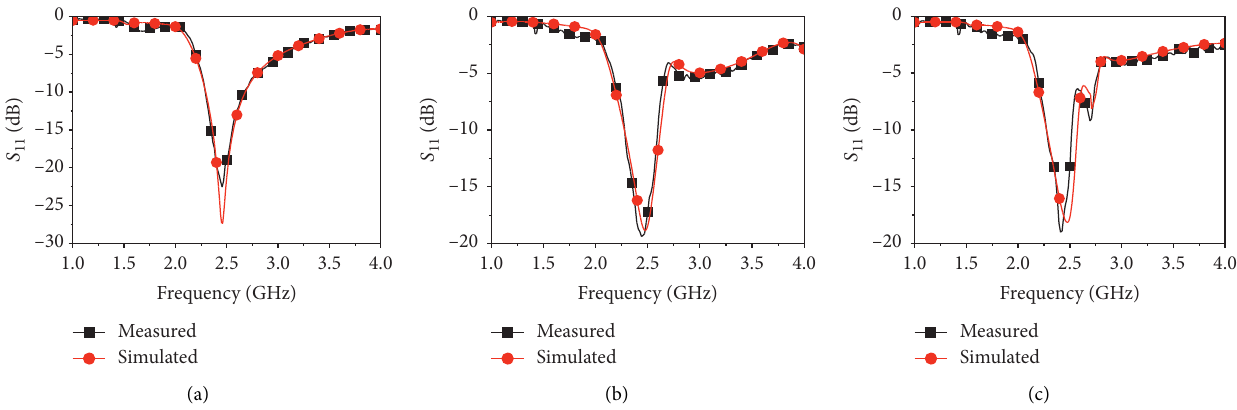
Figure 11: S 11 comparison of the fabricated quasi-Yagi antennas. (a) Reference quasi-Yagi antenna with straight arms (90mm). (b) Compact rectangle quasi-Yagi antenna with bent arms (65 mm). (c) Compact trapezoid quasi-Yagi antenna with bent arms